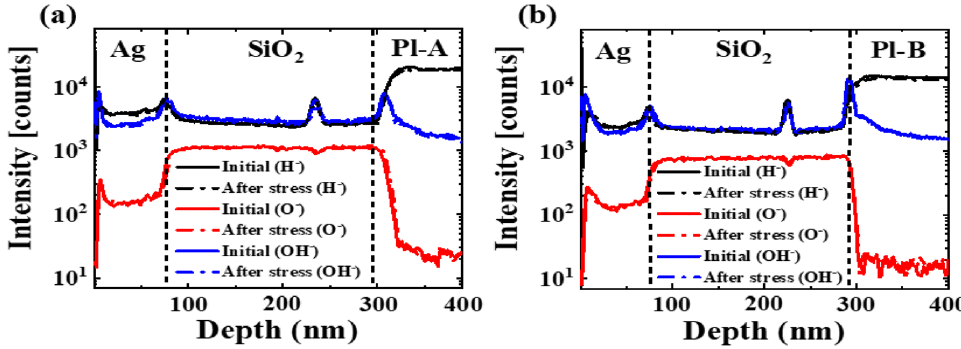
Figure 6. Hydrogen, hydroxy group and oxygen profiles obtained by SIMS measurements of capacitors before/ after bias stress; ( a ) Ag/SiO 2 /PI-A/Ag and ( b ) Ag/SiO 2 /PI-B/Ag.